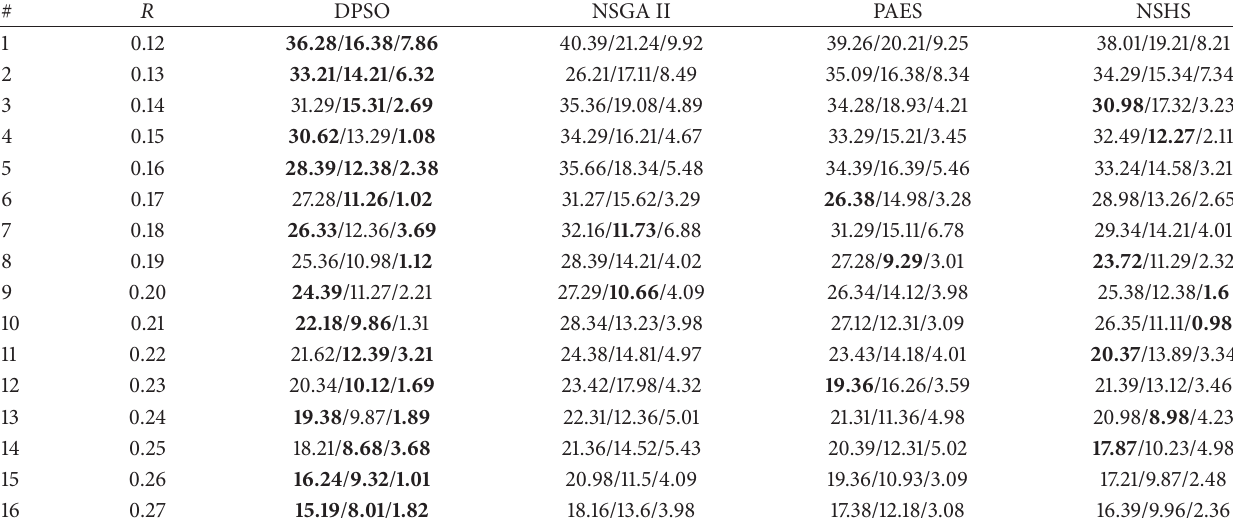
Table 7: The algorithms of the NLE values (mean/minimum/standard